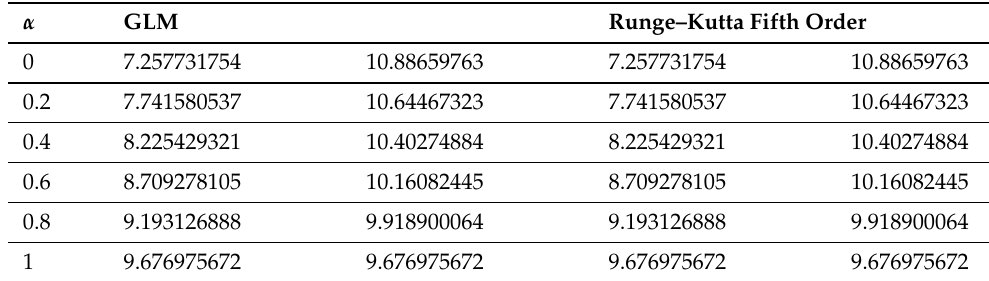
Figure 6. Exact(line) and GLM 1-solutions(stars) for Example 2 when t = 1.0, 1.5 and 2.0 with triangular fuzzy numbers as the initial conditions. Table 11. Comparison between the GLM and the Runge–Kutta fifth order for the 1-solution at t =